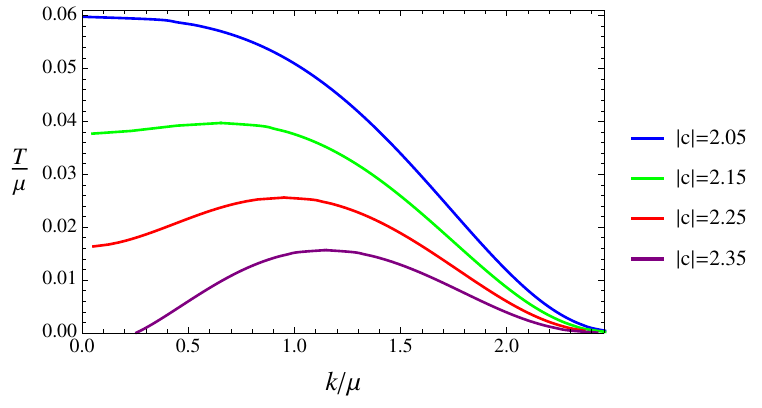
Figure 2 . Critical temperature as a function of wave number, for di(cid:11)erent choices of coupling c . From top to bottom the coupling is increased. We have m 2 = (cid:0) 8 ; m 2 q A =